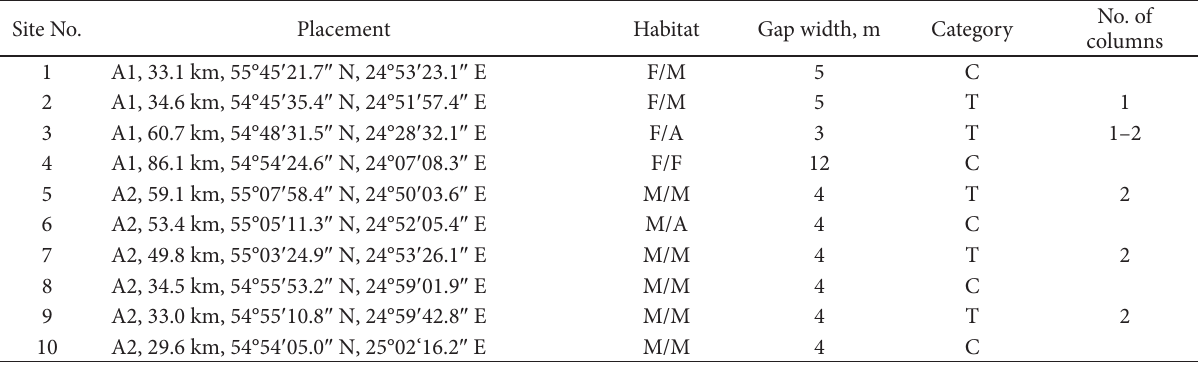
Table 1. Characteristic of investigation sites. Site numbers correspond to Fig. 1 Site No. Placement Habitat Gap width, m Category